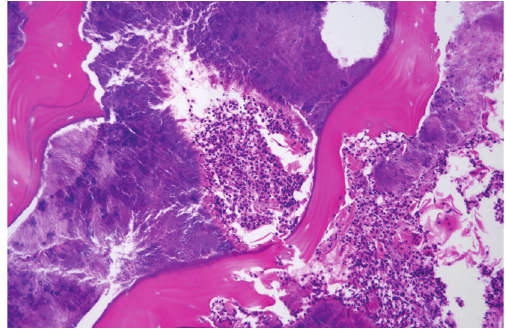
Figure 6: Acute osteomyelitis. Bony sequestrae are surrounded by colonies of bacteria as well as purulent infiltrate.